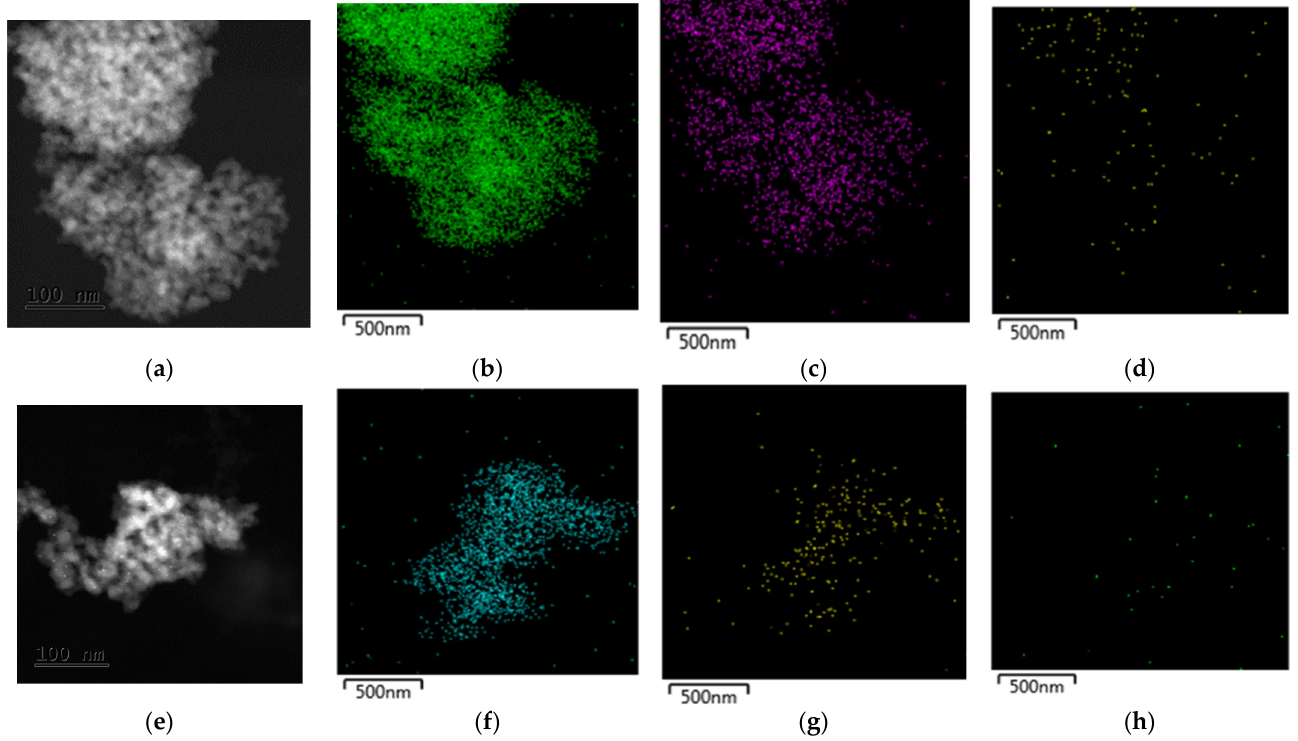
Figure 2. Raman spectrum for the support system TiO 2 , TiO 2 -CeO 2 (1, 5, 10 wt%): ( a ) Sol-gel and ( b ) Impregnation.